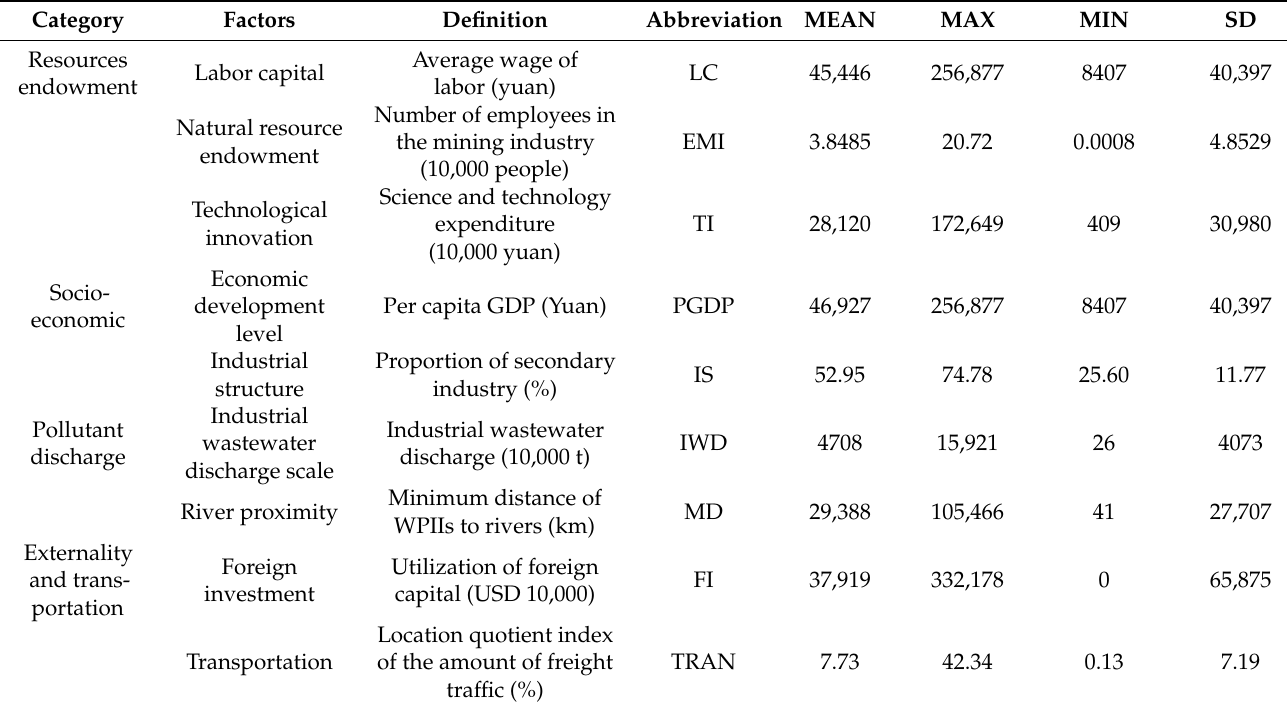
Table 3. Description of influencing